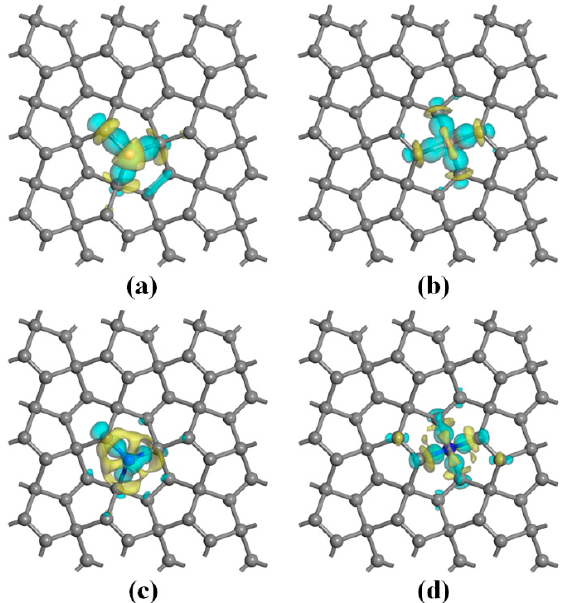
Figure 5. Isosurface plots of electron density differences for the ( a ) PG – B ( sp 2 ), ( b ) PG – B ( sp 3 ), ( c ) PG – N ( sp 2 ) and ( d ) PG – N ( sp 3 ) systems with the isovalues of ± 0.06 a.u. The cyan and yellow represent charge accumulation and depletion, respectively.